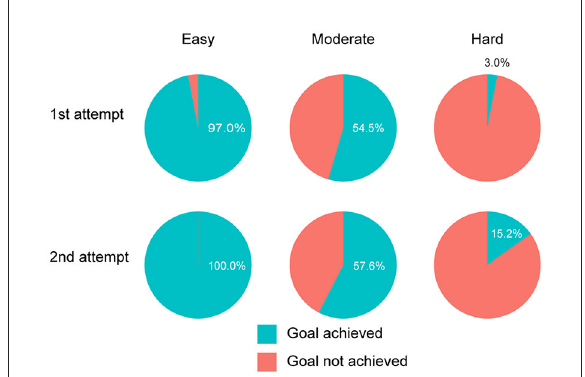
FIGURE4 Percentage of participants who achieved the goal score for each level of goal score and attempt. Almost all participants achieved the easy goal and did not achieve the hard one. The percentage of participants who achieved the moderate goal was approximately 50% in both attempts.